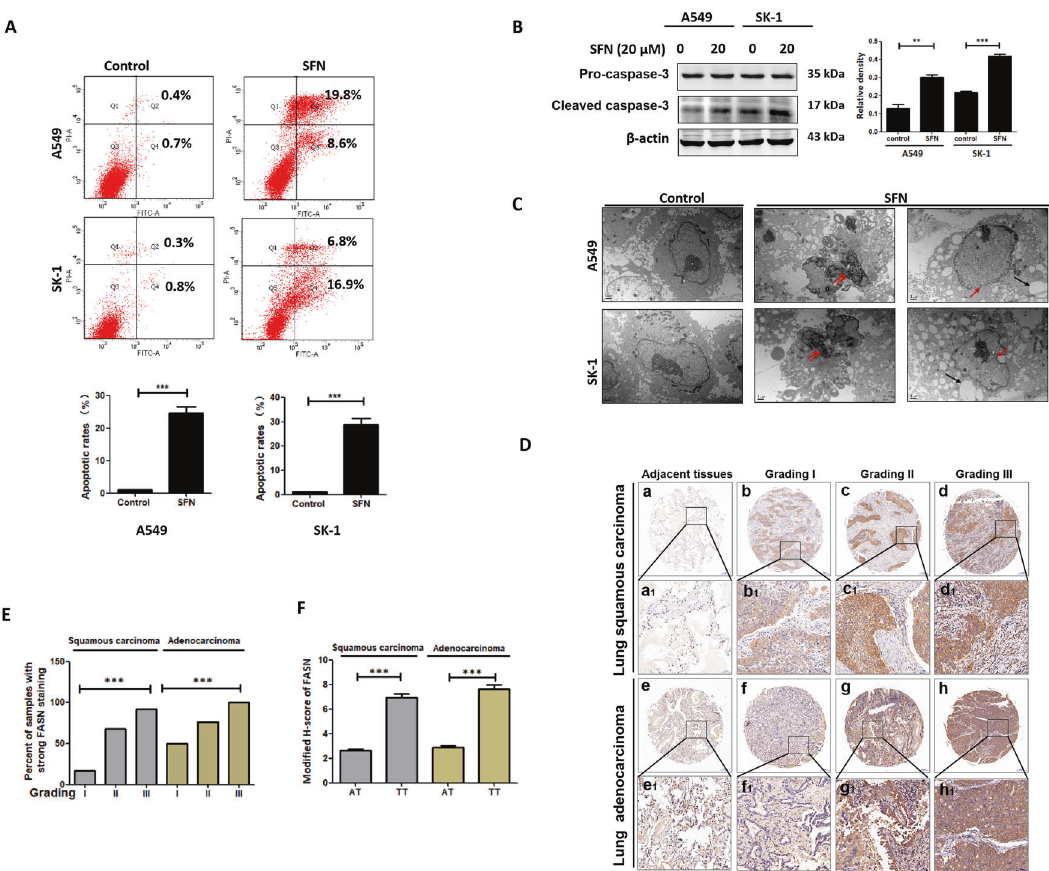
Fig. 1 SFN-induced apoptosis might result from the inhibition of microtubule-mediated FA synthesis. A Both of A549 and SK-1 cells were treated with SFN (20 µM) for 24 h, then the cells were collected and the percentages of cell apoptosis were analyzed by a fl ow cytometer. B Caspase-3 proteins were analyzed via western blotting in A549 and SK-1 cells treated with SFN (20 µM). C After induction with 20 μ M SFN, both A549 and SK-1 cells were collected and fi xed. Cell pellets were cut into thin slices and stained with uranium acetate and lead nitrate. Cell morphology was viewed with TEM. Double red arrows marked nuclear fragments, black arrows indicate sporadic vacuoles, and red arrows indicate membrane disruption. Scale bar: 1 μ m. D Levels of FASN were assessed in the microarray tissues of lung adenocarcinoma and lung squamous carcinoma. FASN levels in the 150 adjacent tissues were tested as the controls ( A , E ) and 150 cancer tissues with three malignant grades ( B – D , F – H ) were used. Upper panel: magni fi cation ×50, scale bars: 500 μ m. Lower panel: magni fi cation ×200, scale bars: 100 μ m. E Percentages of samples with strong FASN staining in 75 tumor tissues, which were divided into three malignant grades. F The comparison of H scores for FASN accumulation between adjacent and tumor tissues were done in lung adenocarcinoma and lung squamous carcinoma (AT: 75 adjacent tissues; TT: 75 tumor tissues). Data were shown as means ± SEM ( n ≥ 3). ** P ≤ 0.001; *** P ≤